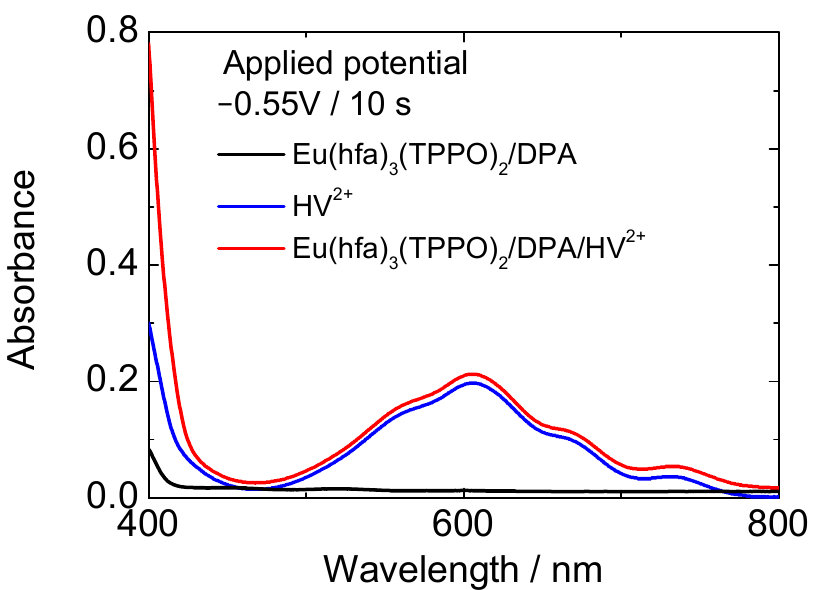
Figure 3. Absorption spectra of the electrolyte solutions in three-electrode cell under application of reduction potential of − 0.55 V for 10 s (black line: Eu(hfa) 3 (TPPO) 2 /DPA, blue line: HV 2+ , red line: Eu(hfa) 3 (TPPO) 2 /DPA/HV 2+ ).